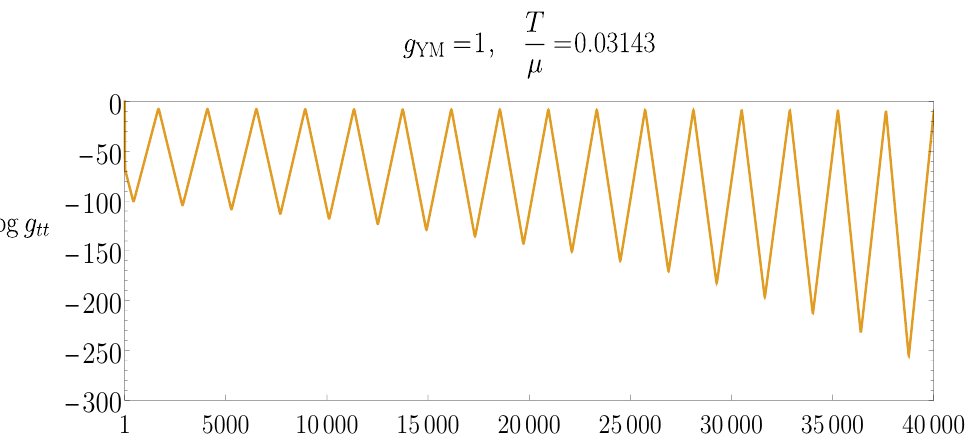
Figure 16. Large- z plot for function zχ 0 at ω h 0 = 2 . 05 . The function demonstrates a large number of oscillations by virtue of the many plateaus. These plateau oscillations are centred around zχ 0 = 2 , which is the value that sets n h = 1 . The oscillation amplitude grows with z and at very large z the numerics becomes unstable.